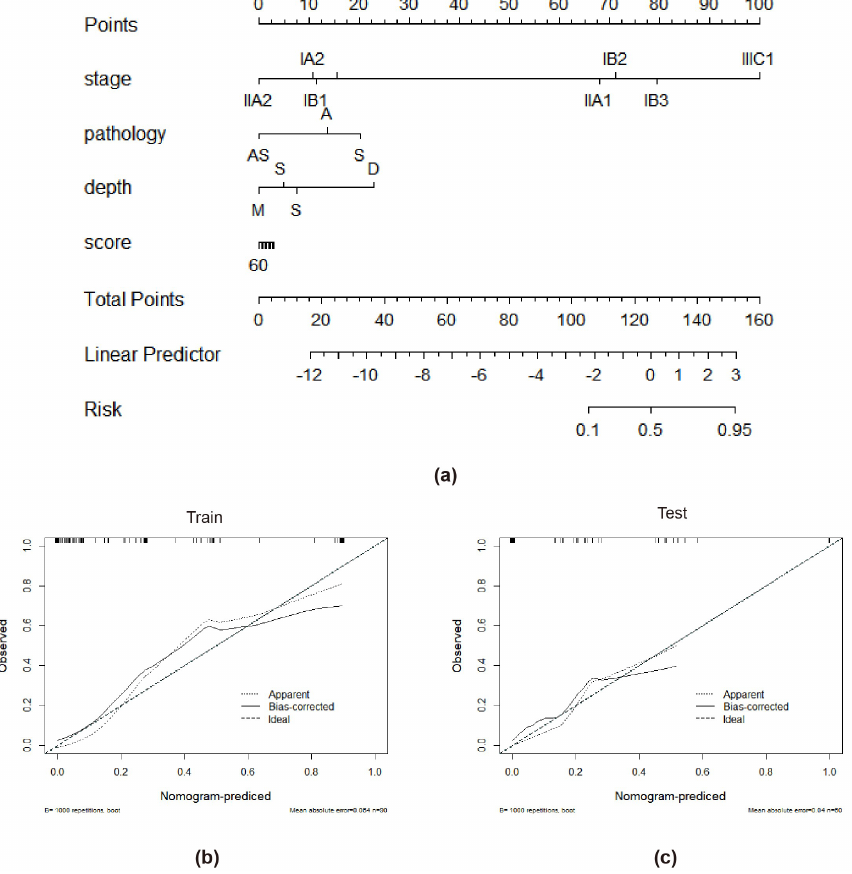
Figure 6. The radiomics-based nomogram ( a ). Calibration curves in the training cohort ( b ) and validation cohort ( c ). A closer fit to the diagonal line indicates a better